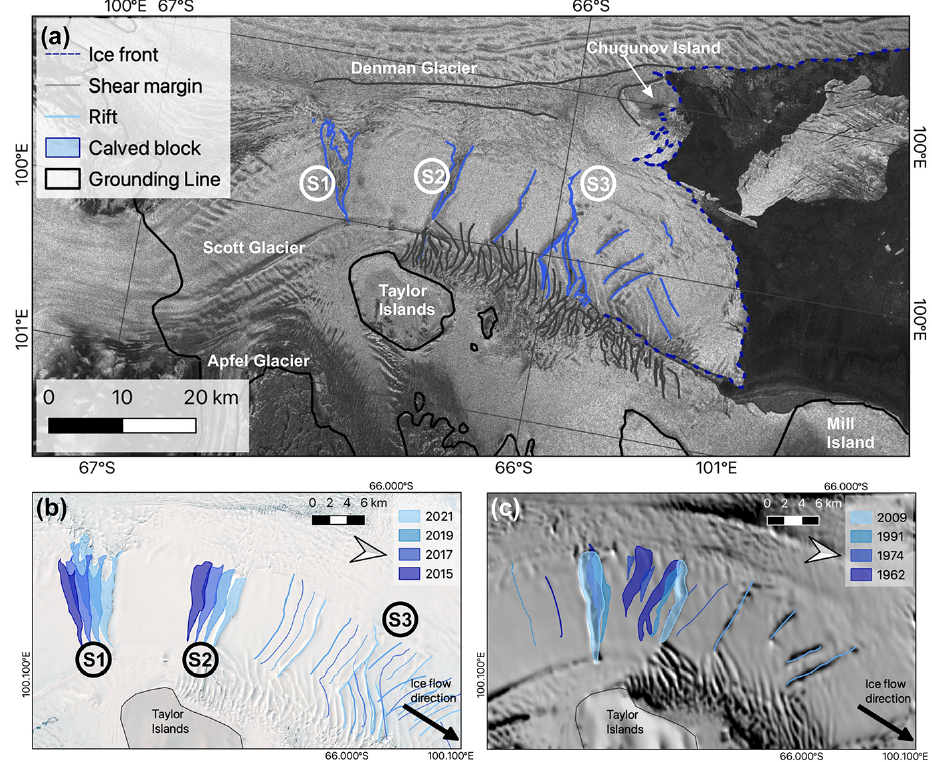
Figure 4. Evolution of the rifts on Scott Glacier from (a) 2015–2022 mapped from Sentinel 2B (acquired on 27 February 2021), Landsat 8 OLI (acquired on 16 February 2019 and 25 March 2015) and from Sentinel 2A (acquired on 23 February 2017) (background: Sentinel 2B acquired on 27 February 2021) and (b) 1962–2009 mapped from ARGON KH-5 (acquired on 16 May 1962), Landsat 1 MSS (acquired on 27 February 1974) and Landsat 5 TM (acquired on 10–12 February 1991) and from MODIS MOA (acquired on 1 November–28 February 2009) (Scambos et al., 2007) (background: MODIS MOA). (c) The floating portion of Scott Glacier in June 2022, highlighting the iceberg that calved from the western front in April 2022 and the rifting across the eastern portion of the front towards Chugunov Island (background: Sentinel 1A acquired on 6 June